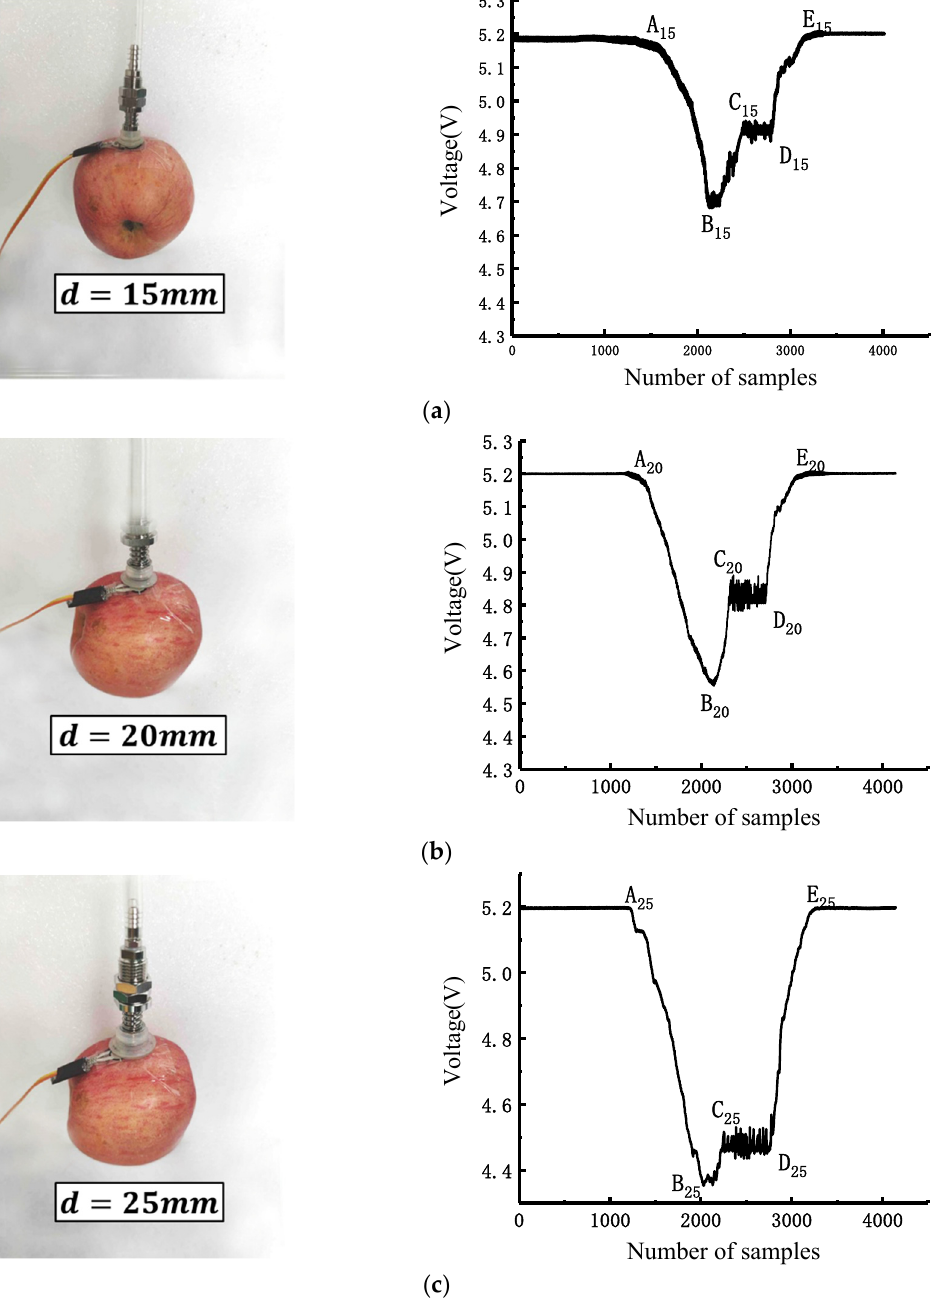
Figure 27. Single suction cup adsorption force experiment and results: ( a ) suction cup diameter d = 15 mm; ( b ) suction cup diameter d = 20 mm; ( c ) suction cup diameter d = 25 mm.